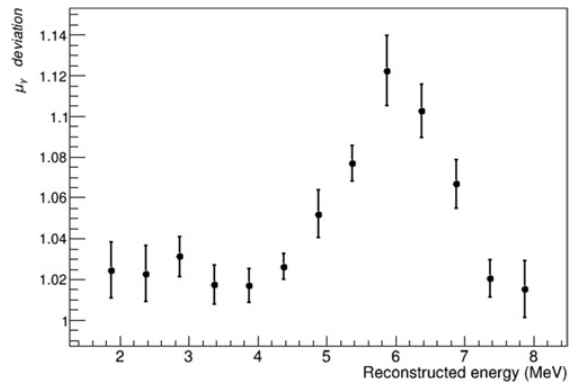
Figure 4. Relative deviation of the mean ( µ γ ) electron-recoil PSD component for IBD-like background events compared to single events. Distributions were fitted with Gaussian functions using Eq. (2) for each cell and the average values over the six cells are reported. Uncertainties take into account the deviation between cells.